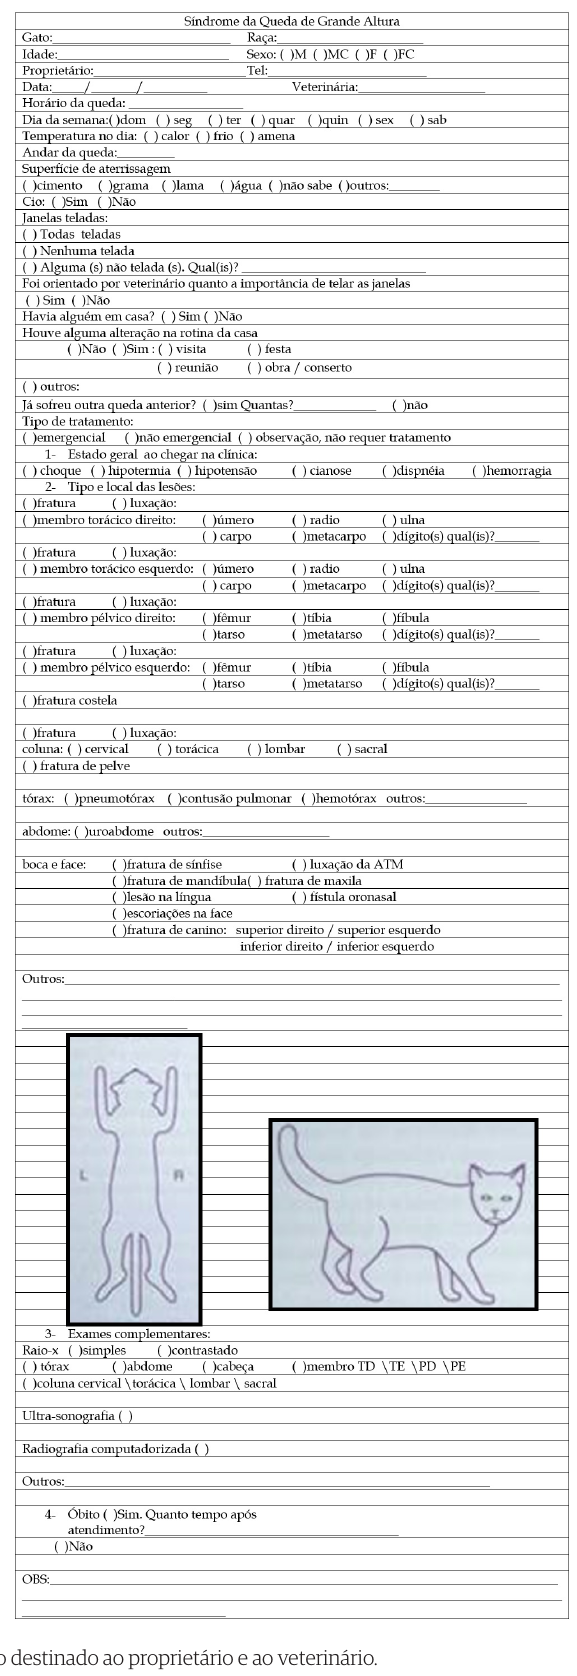
Figura 1. Questionário destinado ao proprietário e ao